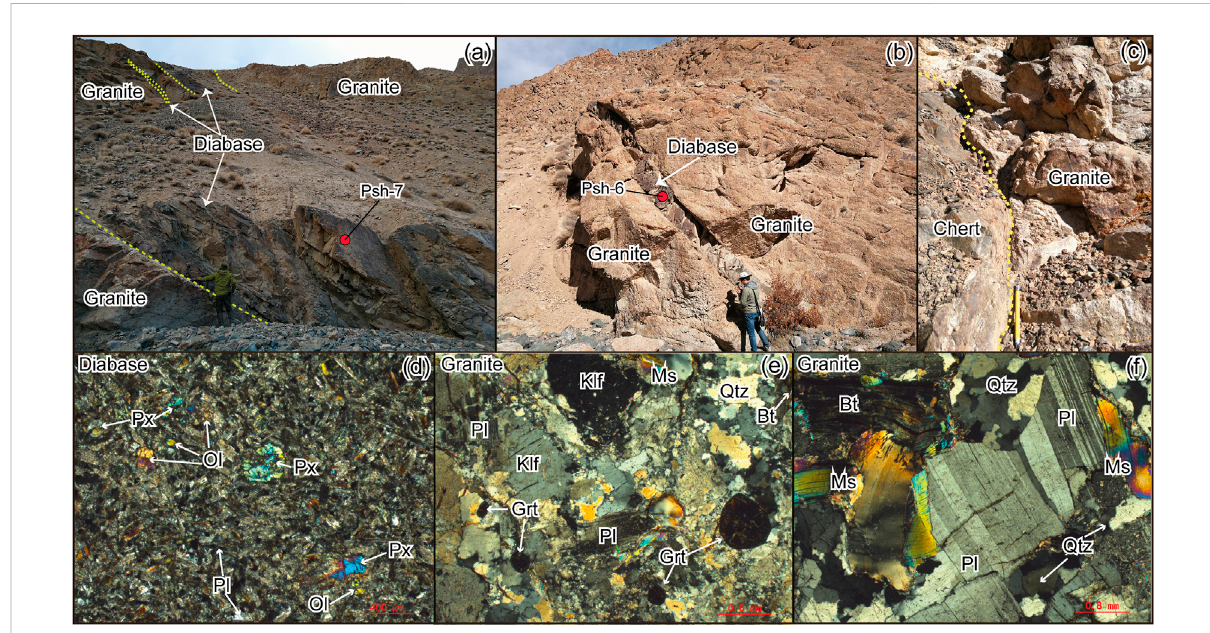
FIGURE 3 (A,B) Variablysizeddiabasedikesintrudingintothegraniticrocks.TheirlocationisshowninFigure2B.Scientistsforscale. (C) Intrusioncontacts between chert and invaded granite. (D) Photomicrograph of diabase rocks, the location of which is shown in Figure 2B. (E,F) Photomicrographs of granites. Px, pyroxene; Ol, olivine; Pl, plagioclase; K fl , K-feldspar; Ms, muscovite; Bt, biotite; Qtz, quartz; Grt,